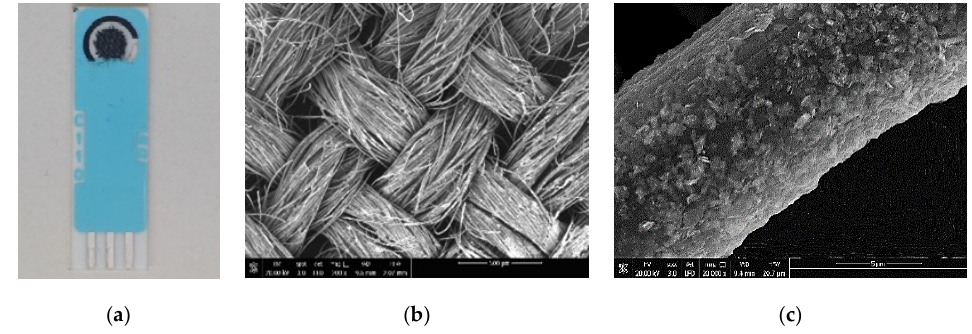
Figure 1. ( a ) Picture of the modified 2D-MoS 2 -MoO 3 -CC/screen-printed carbon electrode (SPCE); ( b ) SEM image of the 2D-MoS 2 - MoO 3 -CC network. ( c ) SEM image of the surface of a single 2D-MoS 2 -MoO 3 -CC/SPCE fiber.